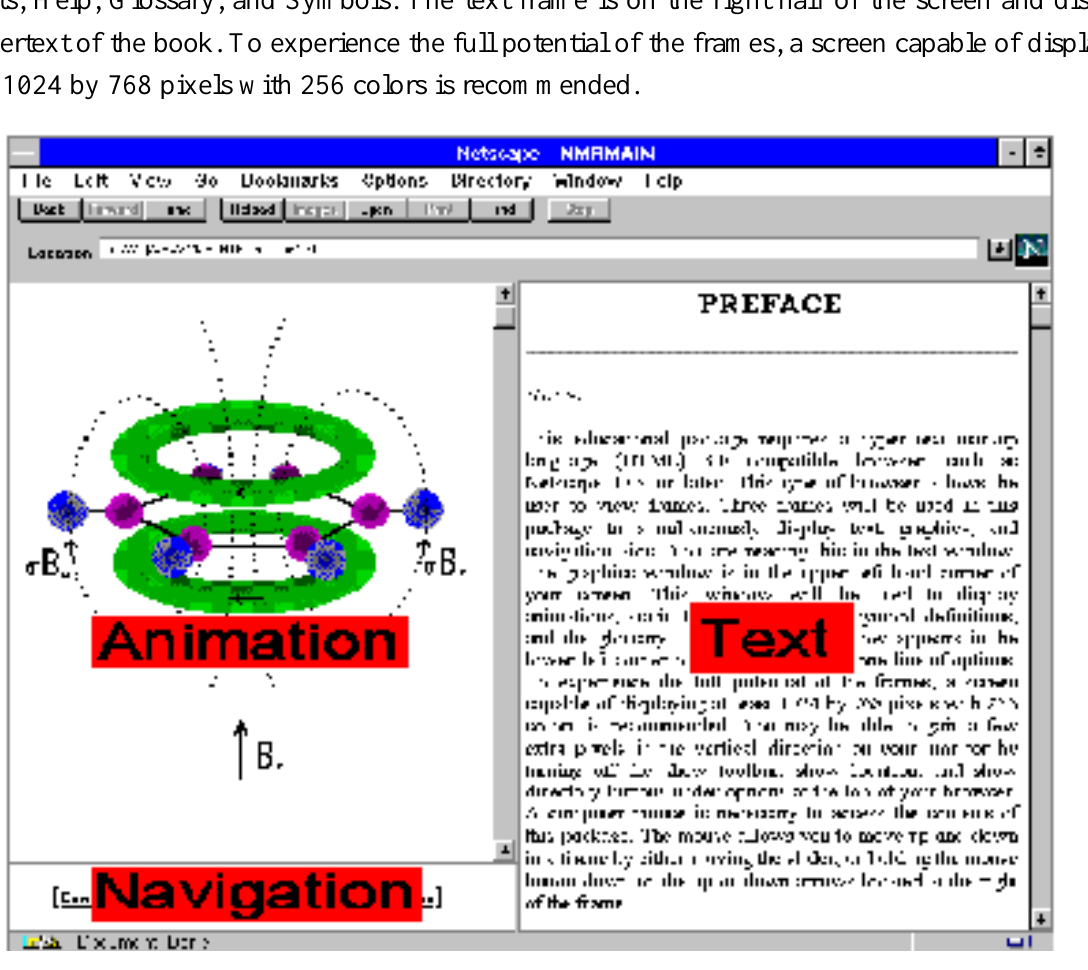
Figure 1. Position of the three frames in The Basics of NMR , © 1997 J.P. Hornak